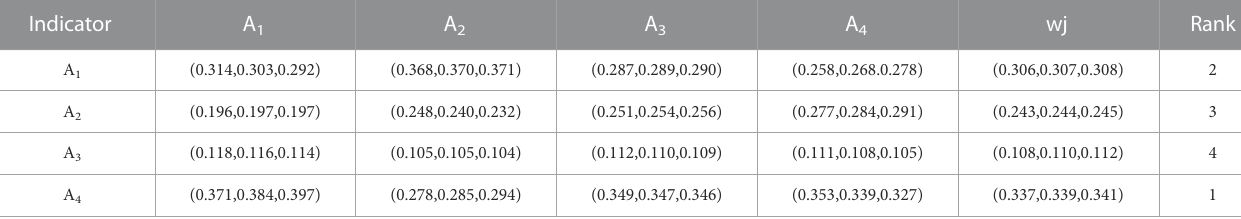
TABLE 10 Standard weight and ranking of construction preparation factor layer (MCS-AHP).